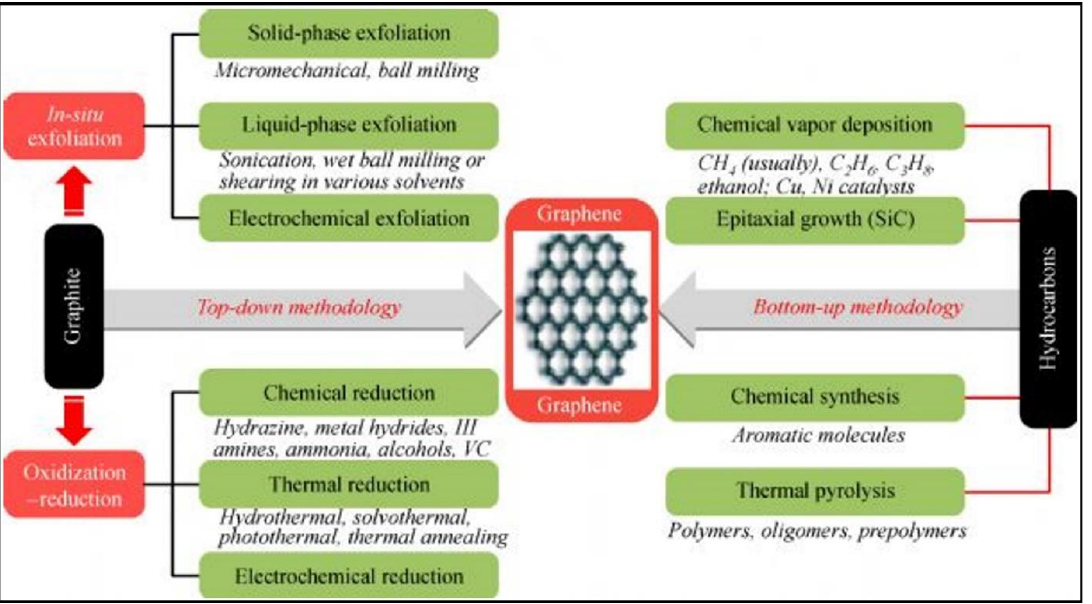
Figure 3. Pathways for graphene production processes (in-situ exfoliation and oxidation reduction) and its utilization by top-down (graphite to graphene) and bottom-up techniques (hydrocarbons to graphene). Reprinted with permission from Ref. [40].